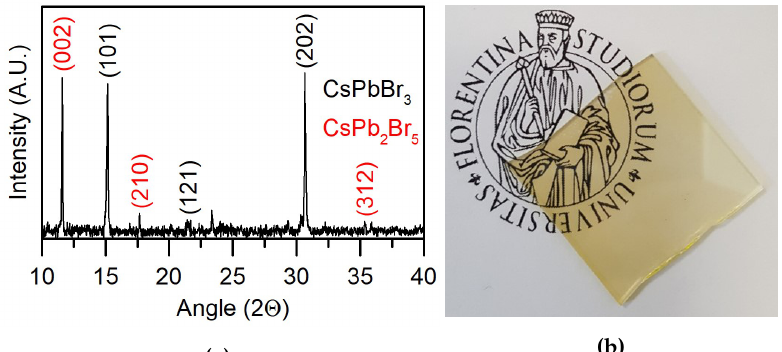
Figure 7. ( a ) XRD spectrum of the thin film. In black are evidenced the peaks of the CsPbBr 3 phase and in red the peaks of the CsPbBr 5 inclusions ( b ) Picture of the obtained transparent thin film.